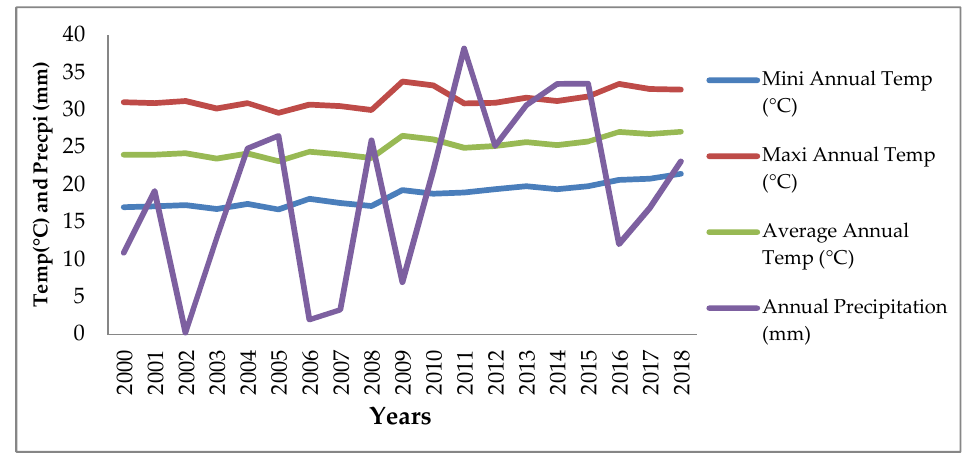
Figure 6. Historical trend of climate change in Punjab, Pakistan Source: Pakistan Meteorological Department (PMD) Dataset.